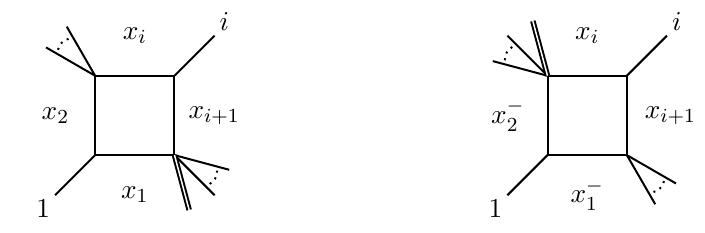
Figure 3 . The two possible types of two-mass easy box functions. The double line represents the incoming momentum q of the operator. Note the two di(cid:11)erent assignments of region momenta in the two